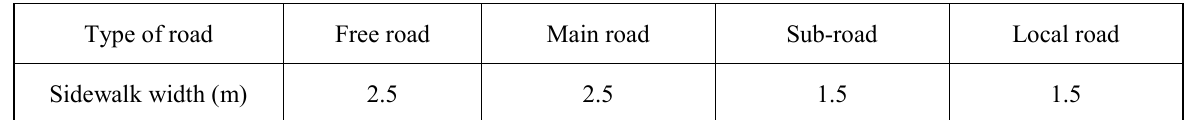
Table 3.Width of the sidewalks in different roads